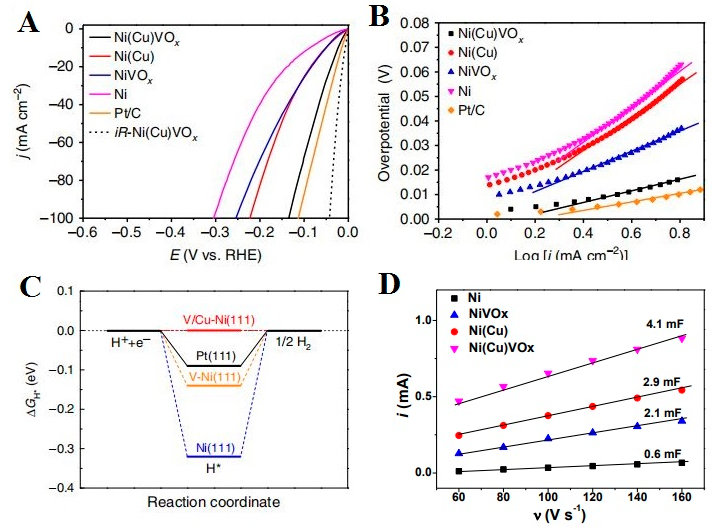
Figure 8. ( A ) Polarization curves of Ni, Ni(Cu), NiVO x , Ni(Cu)VO x , iR -Ni(Cu)VO x and Pt/C. ( B ) Tafel plots of Ni, Ni(Cu), NiVO x , Ni(Cu)VO x , and Pt/C. ( C ) The calculated Δ G H* of Ni(111), V-Ni(111), Pt(111), and V/Cu-Ni(111). ( D ) Double-layer capacitances of Ni, Ni(Cu), NiVO x , and Ni(Cu)VO x calculated from their CVs at different scan rates (reprinted with permission from ref [50]. Copyright © 2020, Springer).